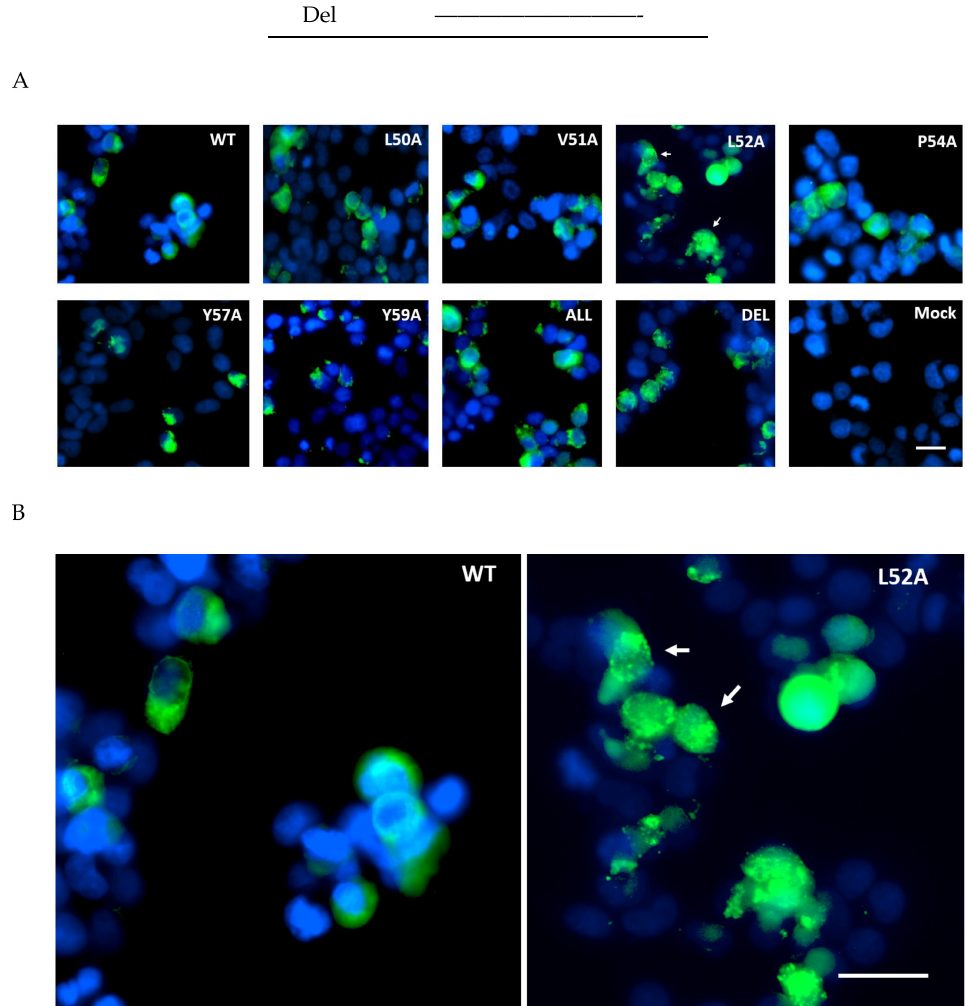
Figure 3. Immunofluorescent staining of MHV E protein expression in Lenti-X 293T cells. ( A ) Cells were transfected with pTriEx1.1 vectors encoding WT MHV-CoV E or various alanine mutants, fixed and permeabilized and detected with anti-His Ab conjugated to Alexa Flour 488 (green). Nuclei were counterstained with DAPI (blue). Punctate staining is indicated. ( B ) Enlarged images of the WT and L52A panels with punctate staining indicated. In both panels the scale bar is 20